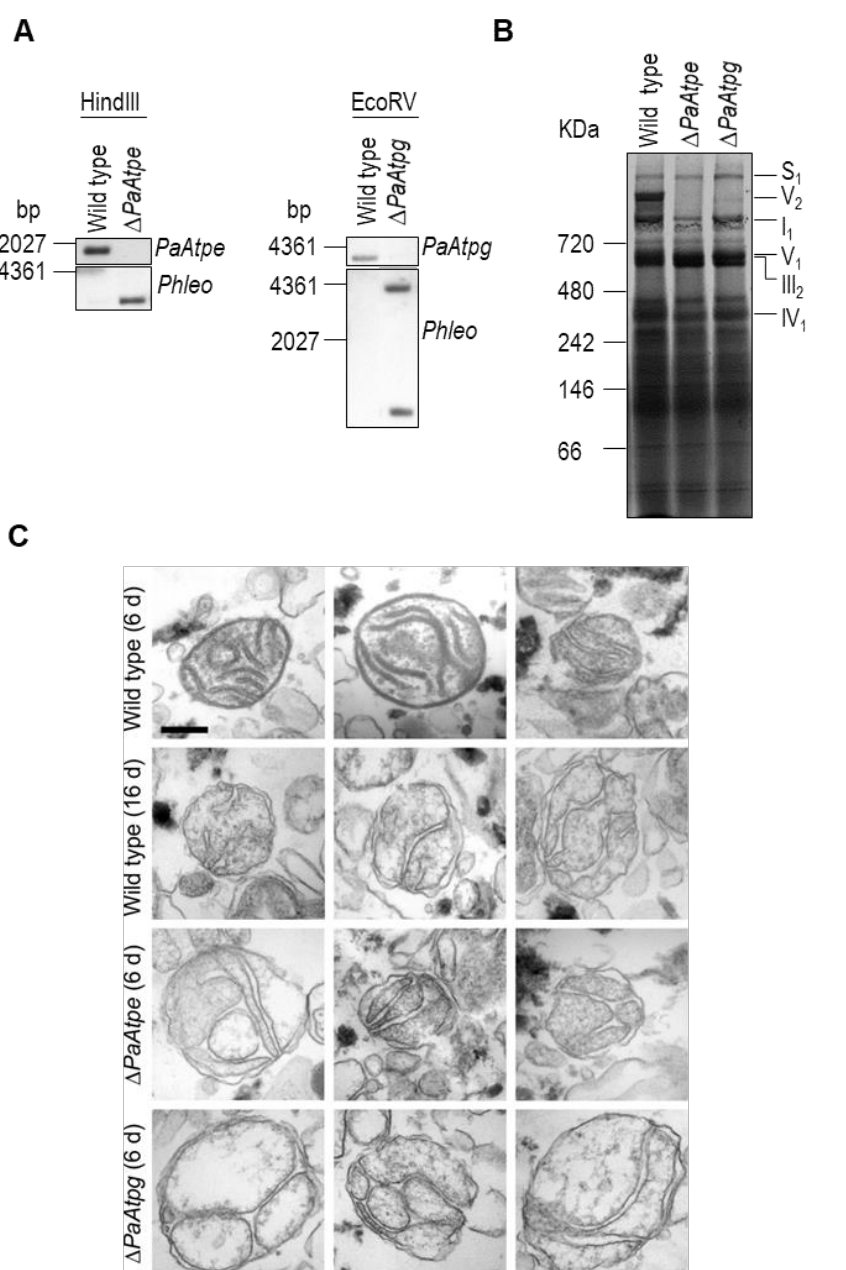
FIGURE 2: Deletion of PaAtpe or PaAtpg affects F 1 F o -ATP-synthase dimer formation and